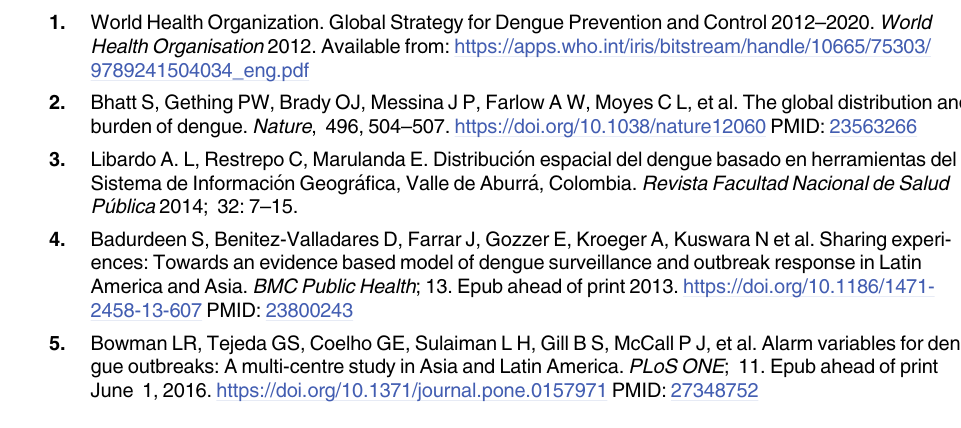
S6 Fig. Timelines of the indoor spraying as vector control and responses activities. Illustra- tion of initial (1), early (2) and emergency/late (3) responses as practiced in non-outbreak dis- tricts based on the prediction generated from the EWARS. S7 Fig. Timelines of the fogging as vector control and responses activities. Illustration of initial (1), early (2) and emergency/late (3) responses as practiced in outbreak districts based on the prediction generated from the EWARS. S8 Fig. Timelines of the fogging as vector control and responses activities. Illustration of initial (1), early (2) and emergency/late (3) responses as practiced in non-outbreak districts based on the prediction generated from the